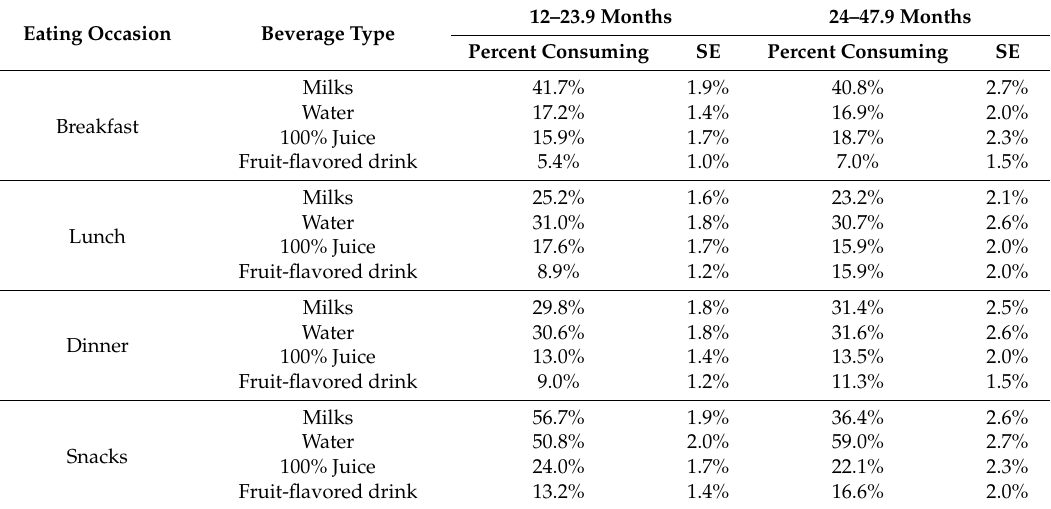
Table 2. Percent ( ± SE) consuming beverages at meal and snack times among young children participating in FITS 2016 ( n =